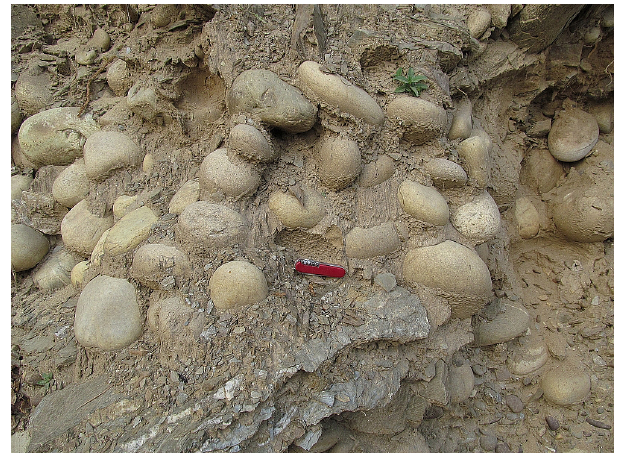
Figure A5. DVDF – terrace deposit ∼ 95m above modern channel. Sample was taken from the base of 4m thick fluvial conglomer- ate layer, capped by more angular phyllite/schist deposit (erosional contact) suggesting input of locally derived landslide/debris flow material. Unit OSL dated at 10000 ± 2000 years (Ray and Srivas- tava, 2010); 90mm long penknife for scale.